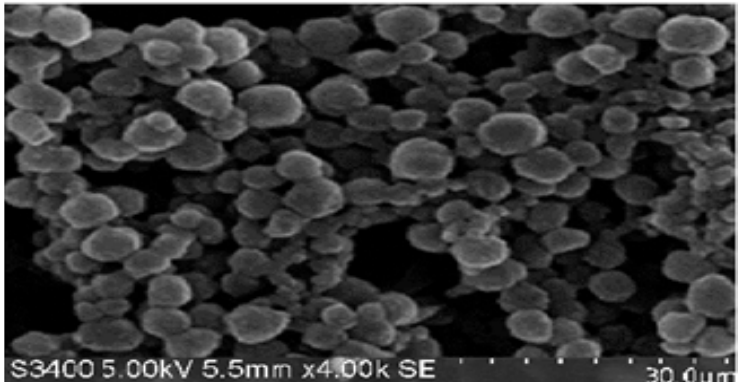
Figure 8. SEM image of the optimized SLN formulation.